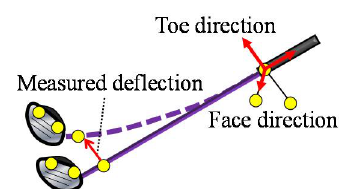
Figure 6. Definition of Path.